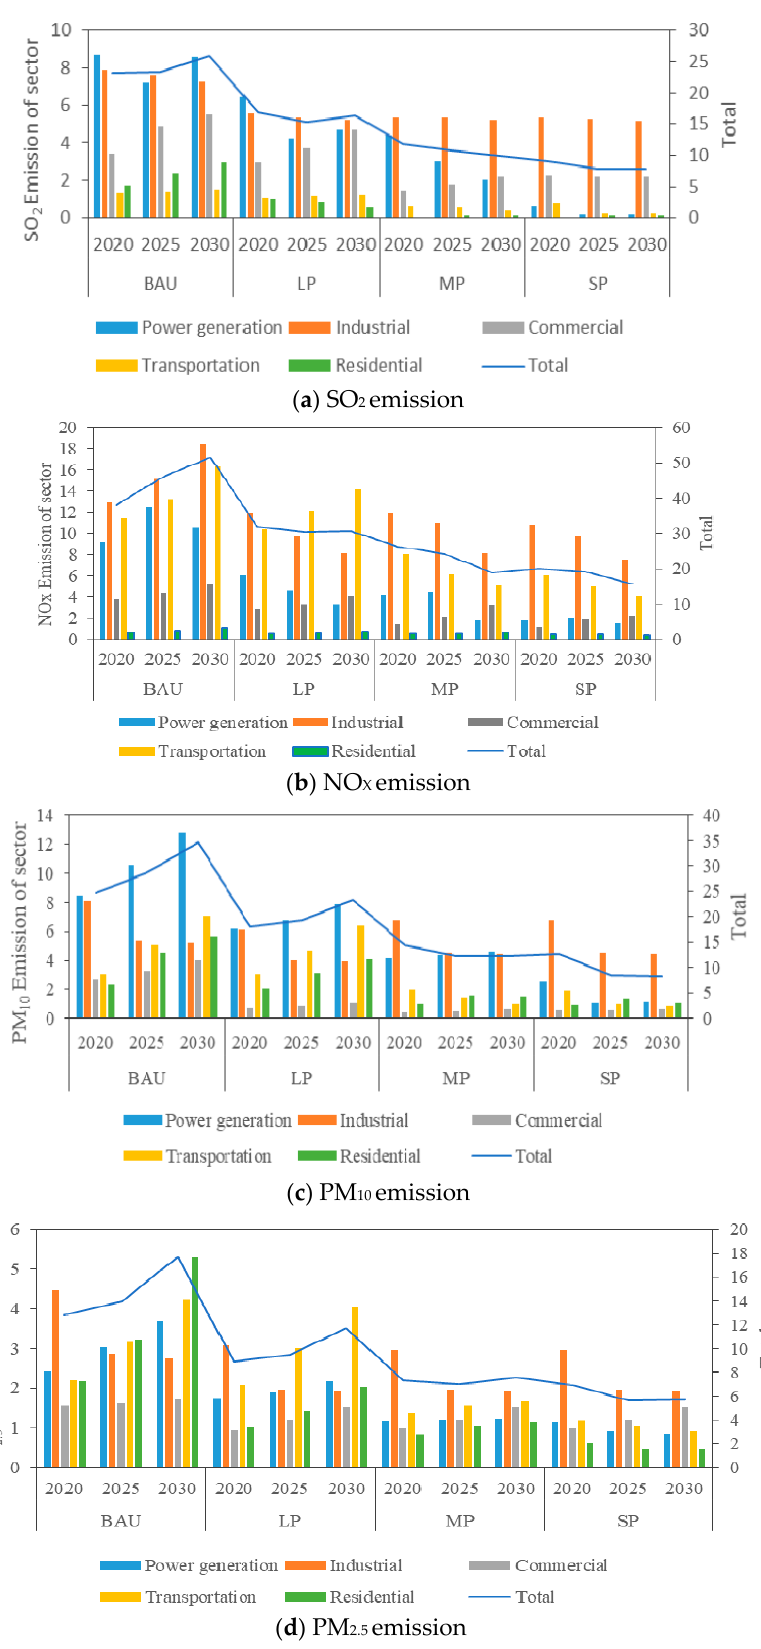
Figure 7. LAPs emissions of energy consumption sectors under different scenarios.